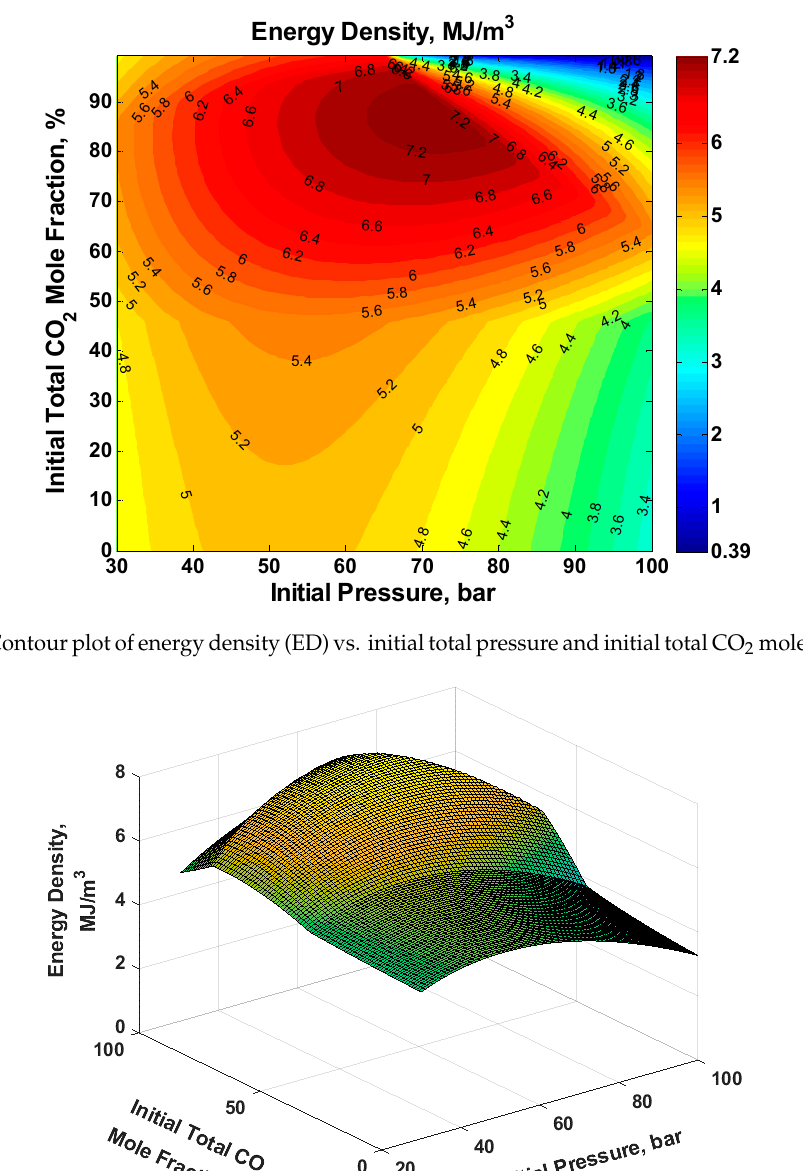
Figure 7. Surface plot of ED vs. initial total pressure and initial total CO 2 mole fraction.